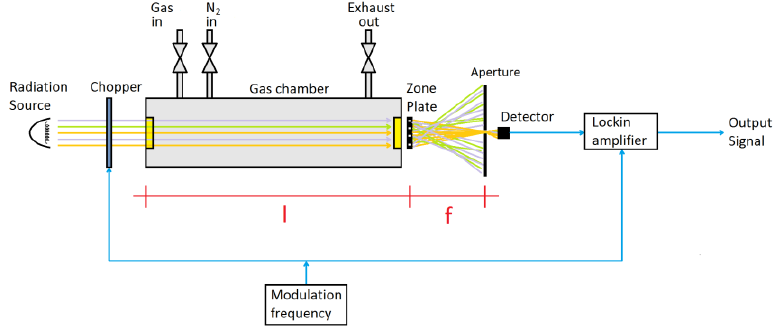
Figure 2. Block diagram of BZP-based